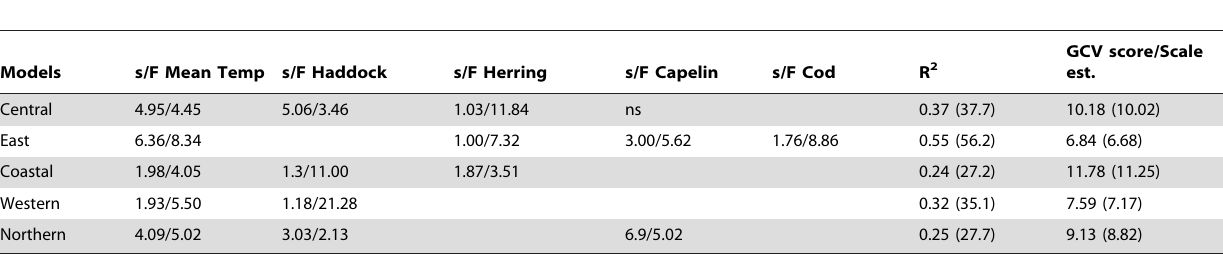
Table 2. Additive models for the relationship between jellyfish, temperature, haddock, cod herring and capelin in the different areas in the in the Barents Sea, adjusted R 2 (i.e. proportion of variance explained), and genuine cross validation (GCV).